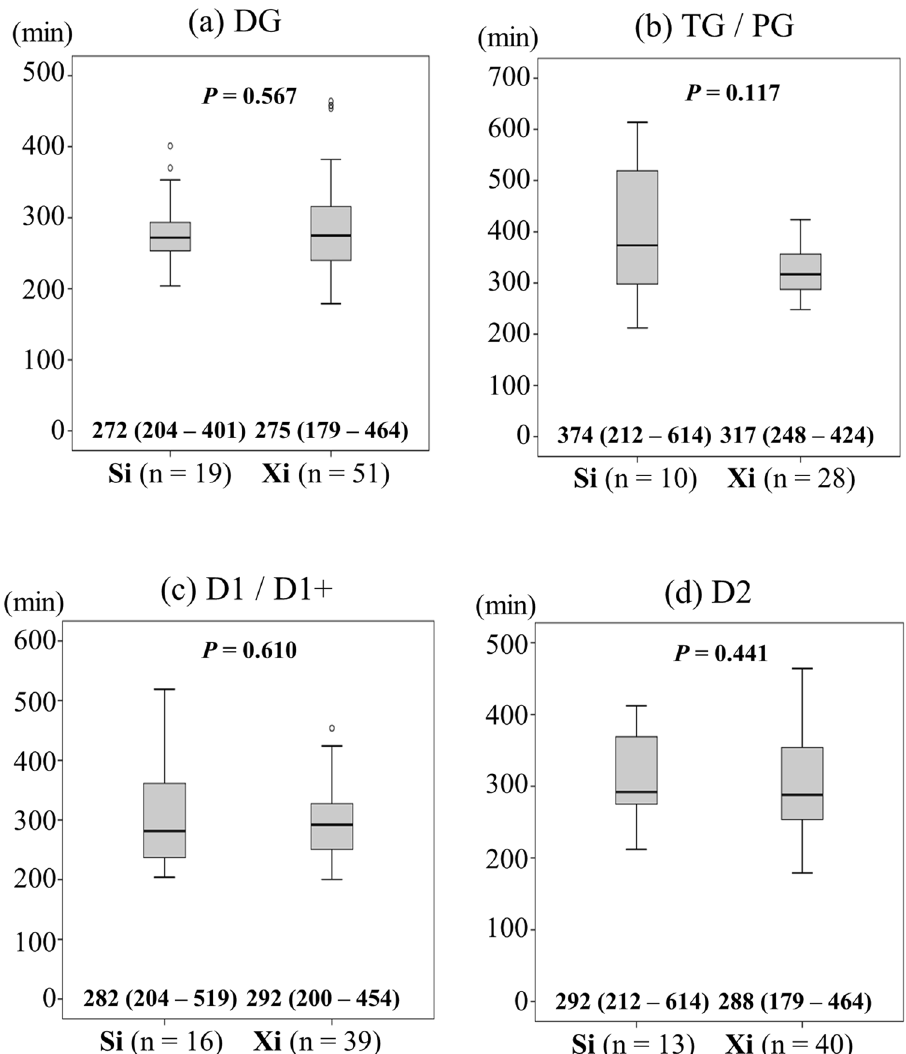
Figure 2. Subgroup analyses of operation time. ( a ) Distal gastrectomy group, ( b ) total and proximal gastrectomy group, ( c ) D1 and D1 + lymph node dissection group and ( d ) D2 lymph node dissection group. Quantitative results are expressed as medians and ranges. The bars in the figure are expressed as means ± SD. P values were calculated with Mann–Whitney U test. Si, da Vinci Si; Xi, da Vinci